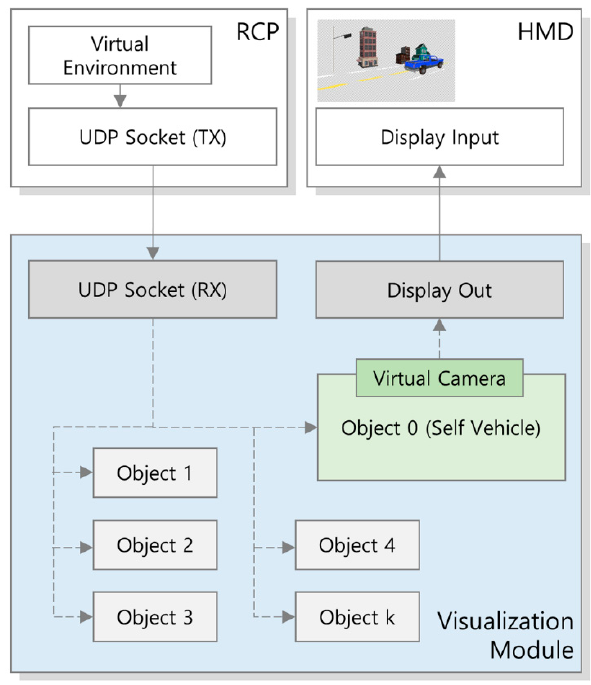
Figure A3. Visualization module structure.